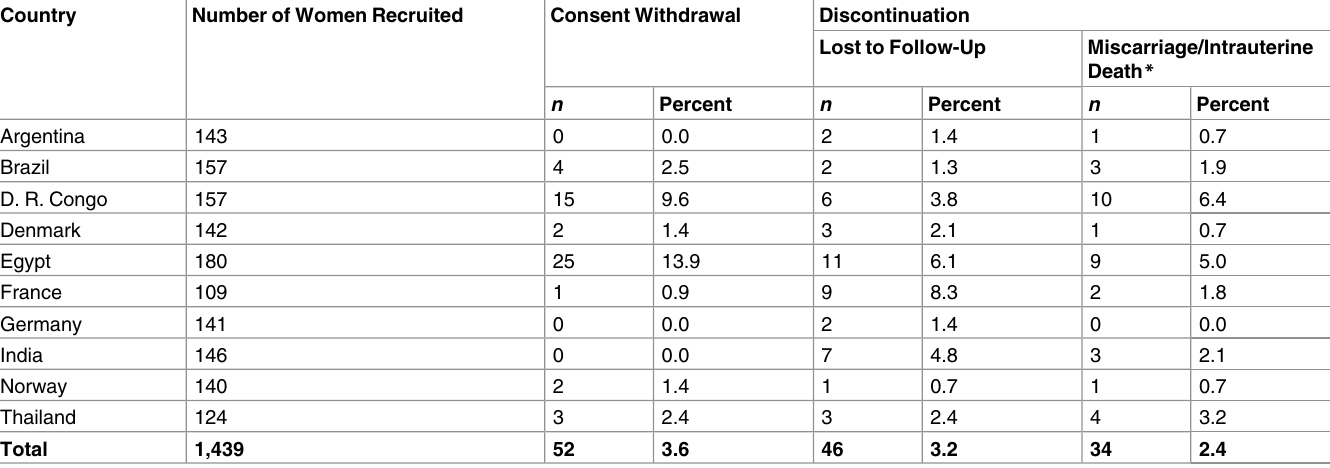
Table 1. Number of women recruited to the study by country, with withdrawals and